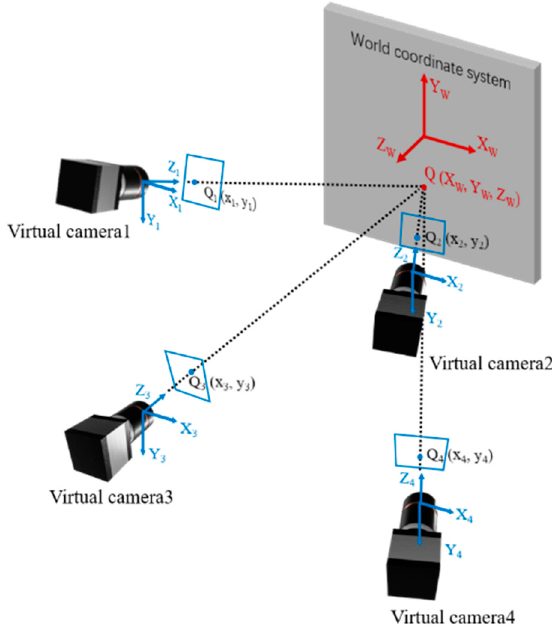
Figure 3. Schematic diagram of the four-view stereo vision.